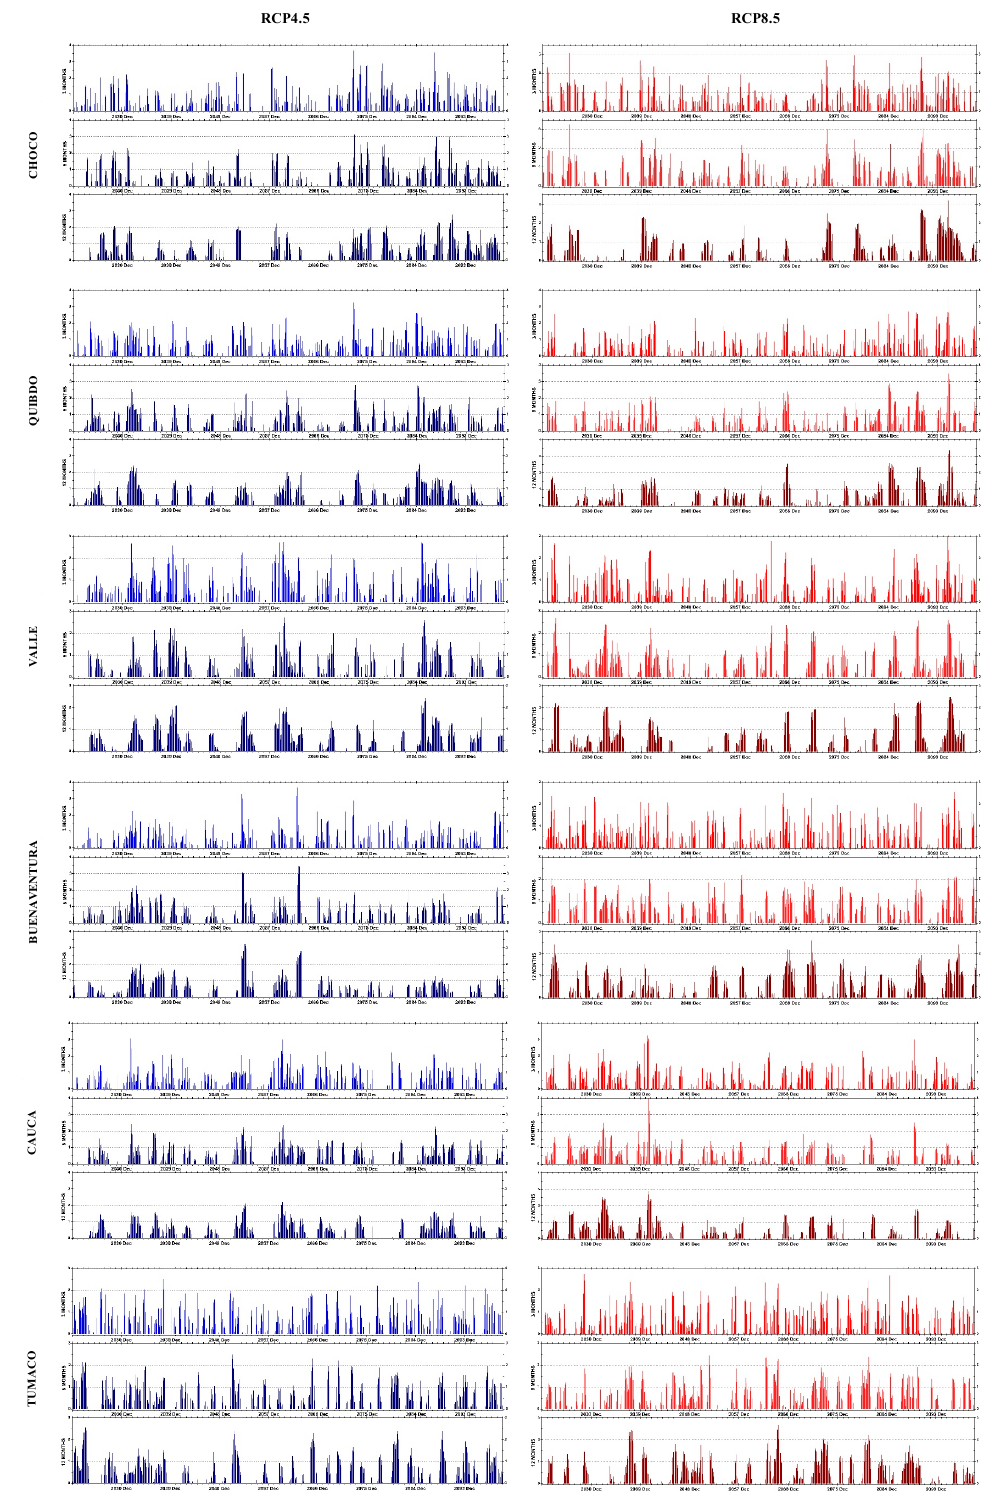
Figure 6. Projected wetness in Colombia’s Pacific region (six locations), 2022–2100. SPIs at different timescales.